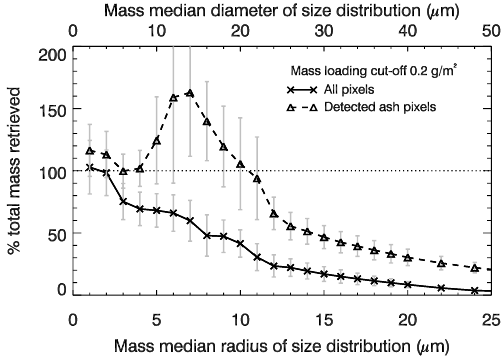
Figure 11. Retrieved mass loading for pixels where retrieved val- ues give good fit to simulated images (i.e. total cost <12) against mass median radius of a lognormal PSD with a geometric standard deviation of 2.0. Data from all 12 cases are combined. Percentage of total mass retrieved is the sum of the retrieved total column load- ings × area, divided by the total mass input into the simulated im- agery from the NAME model. The dashed line includes only those for which volcanic ash was detected in the simulated imagery; the solid line includes all pixels that contained ash in the input NAME data. The error bars show the standard deviation of the